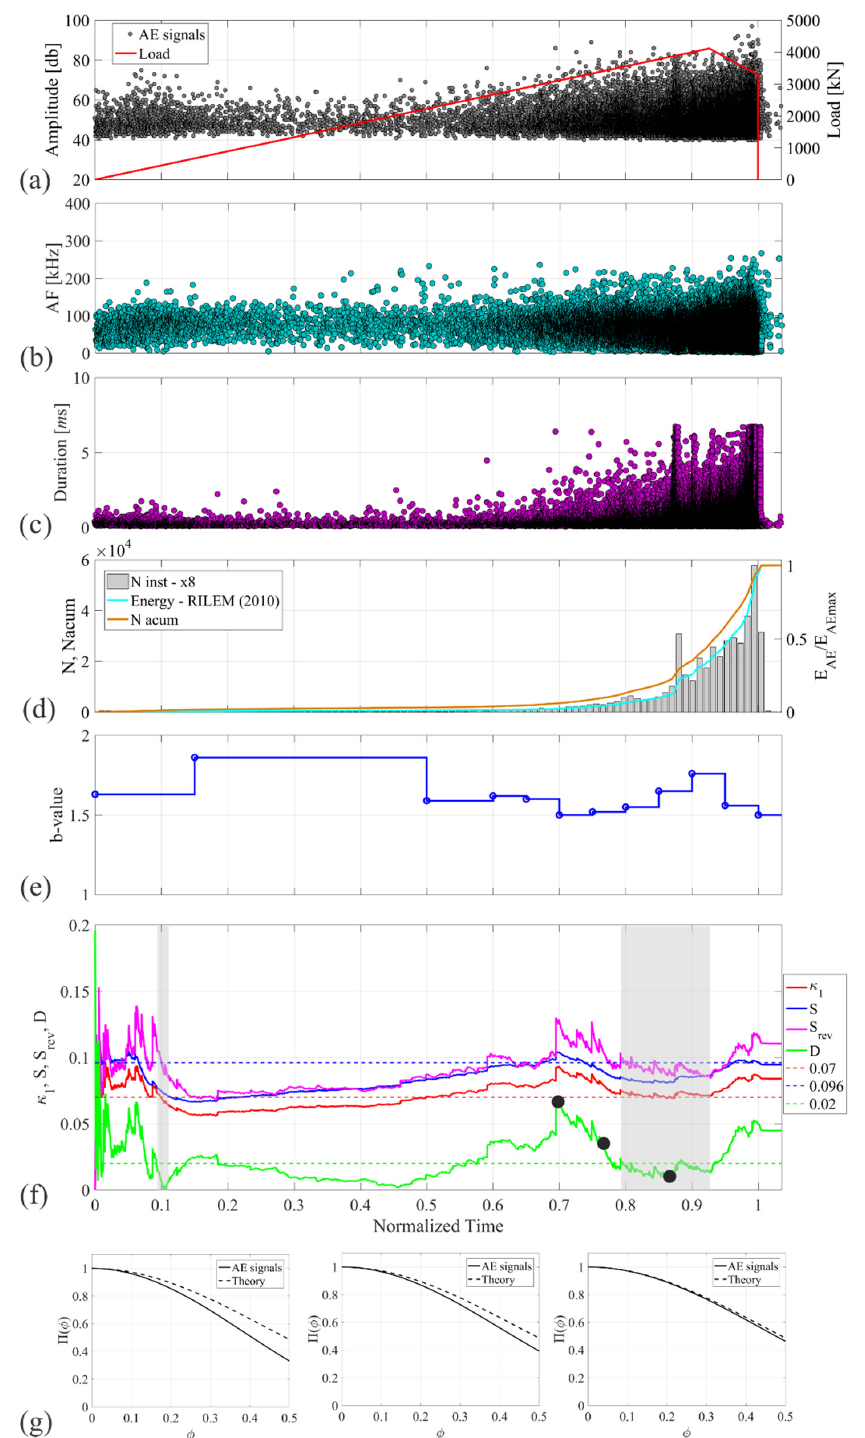
Figure 6. b -value and NT analysis, data from the Mistras system: ( a ) compressive-load and AE signal amplitudes, ( b ) average frequency ( AF ), ( c ) signal duration, ( d ) instantaneous and accumulated signal counts and normalized AE energy ( E AE ), ( e ) b -value evolution, and ( f ) natural time analysis. The horizontal axis is the same for all figures. ( g ) Evolution of Π ( φ ) with AE data from the Mistras system for the true coincidence instants (black circles in ( f )) in normalized time equal to (from left to right): 0.698, 0.7601, 0.8621.